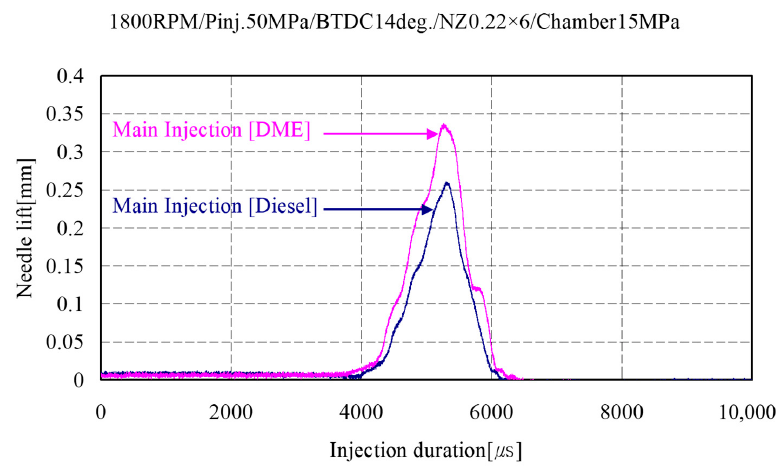
Figure 7. Injection line pressure between the common rail and the injector as a function of the following: without pilot injection of the injection duration for diesel and